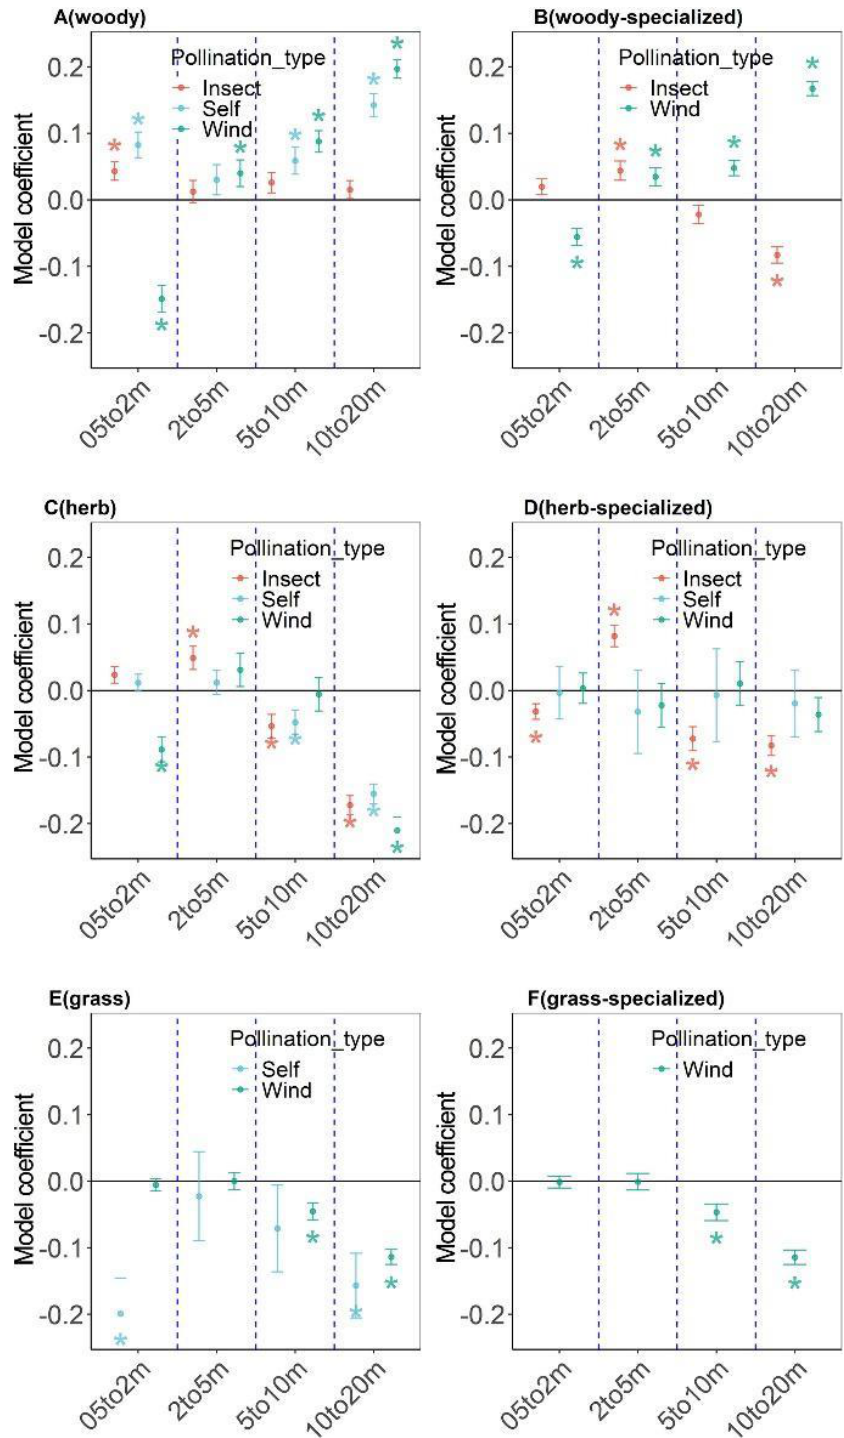
Figure 4. Model coefficients from the generalized linear mixed model (GLMM) of species richness in relation to canopy densities of four vegetation strata. A-B, for woody species with analysis conducted (A) within three groups of insect pollination, wind pollination and self pollination and (B) within three groups of specialized insect pollination, specialized wind pollination and specialized self pollination. C-D, for herbs with analysis conducted (C) within three groups of insect pollination, wind pollination and self pollination and (D) within three groups of specialized insect pollination, specialized wind pollination and specialized self pollination. E-F, for grasses with analysis conducted (E) within three groups of insect pollination, wind pollination and self pollination and (F) within three groups of specialized insect pollination, specialized wind pollination and specialized self pollination. 05to2m means the canopy density of 0.5-2 m vegetation strata. 2to5m means the canopy density of 2-5 m vegetation strata. 5to10m means the canopy density of 5-10 m vegetation strata. 10to20m means the canopy density of 10- 20 m vegetation strata. Y axes indicate coefficients of predictors, which are also listed in Appendix